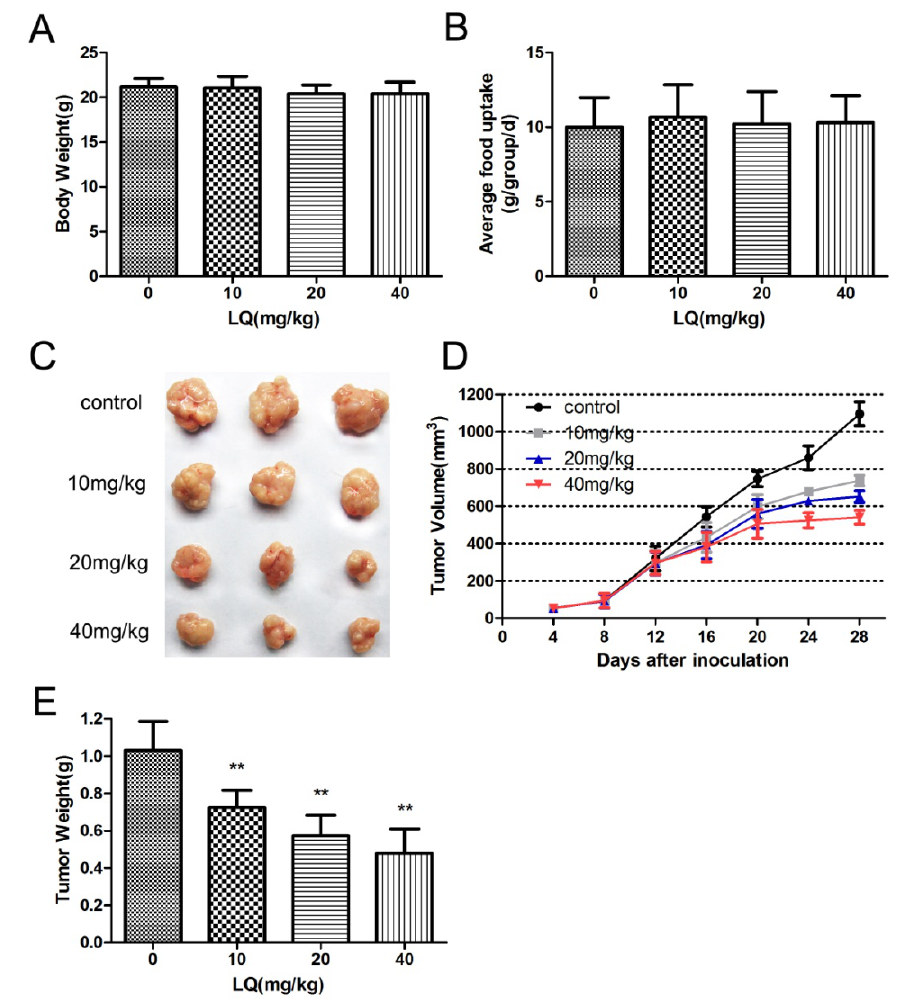
as average tumor mass (g) per site versus group ± SD. ** p < 0.01, compared with control